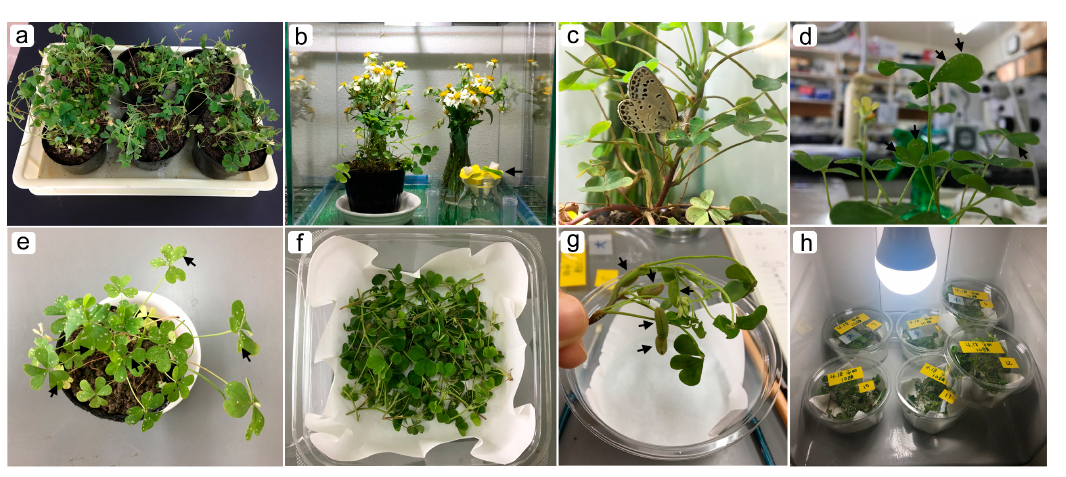
Figure A. Rearing procedures for Z. maha . ( a ) Potted host plant. ( b ) A set up for egg collection from wild-caught females inside a glass tank. ( c ) Oviposition of a female. ( d ) Eggs deposited on the surface of the host plant leaves (arrows). ( e ) Signature of eaten leaves (arrows). ( f ) Host plant leaves inside